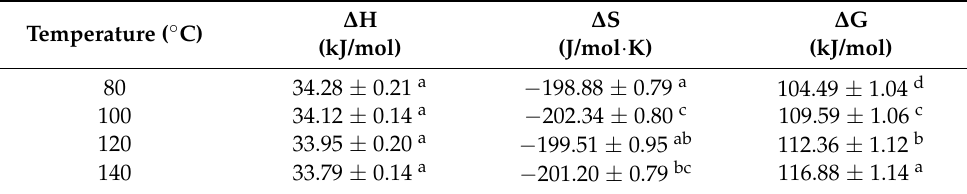
Table 5. Thermodynamic parameters obtained for TFC degradation in red grape skin extract. Temperature ( ◦ C)